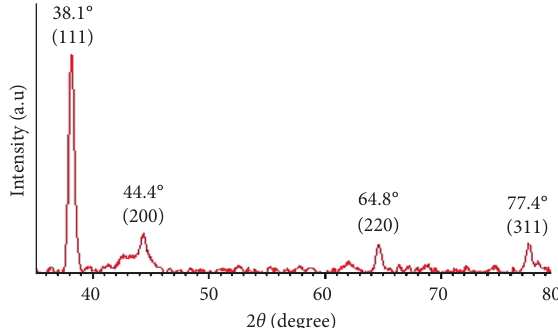
Figure 4: XRD pattern of the AgNPs-pectin powder.